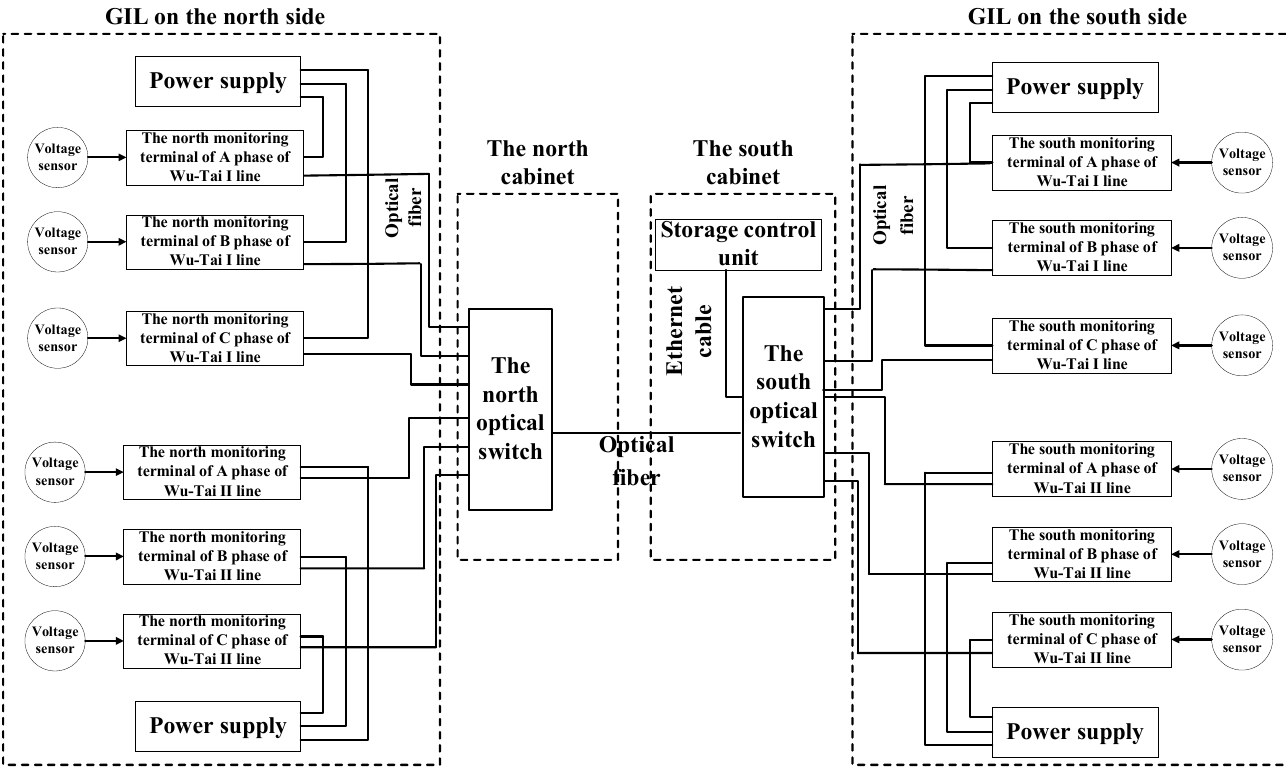
Figure 1. Structure diagram of transient voltage UWB online monitoring system for 1100 kV Sutong GIL project.